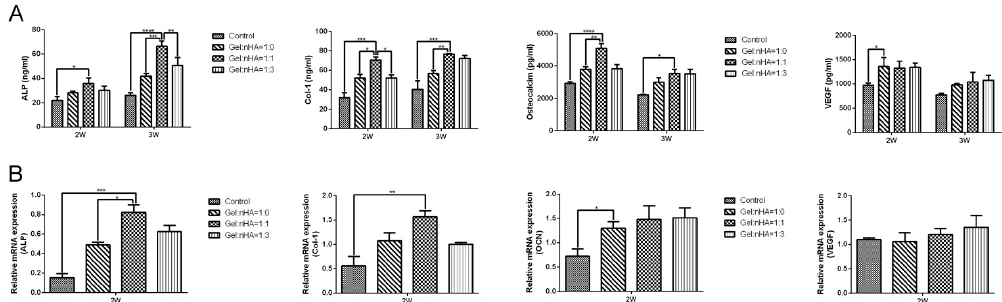
Figure 4. Osteogenesis differentiations of attached cells was assessed by ELISA ( A ) and PCR ( B ) using osteogenic (ALP, Col-1, OCN) and angiogenic (VEGF) markers at 2 weeks and 3 weeks. * p < 0.05, ** p < 0.01, *** p < 0.001, **** p < 0.0001.